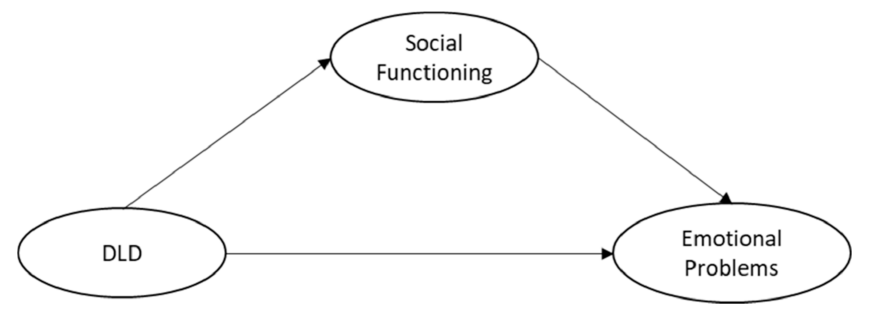
Figure 1. The social mediation hypothesis. This model illustrates the proposed mediating effect of social functioning on the relationship between Developmental Language Disorder (DLD) and emotional